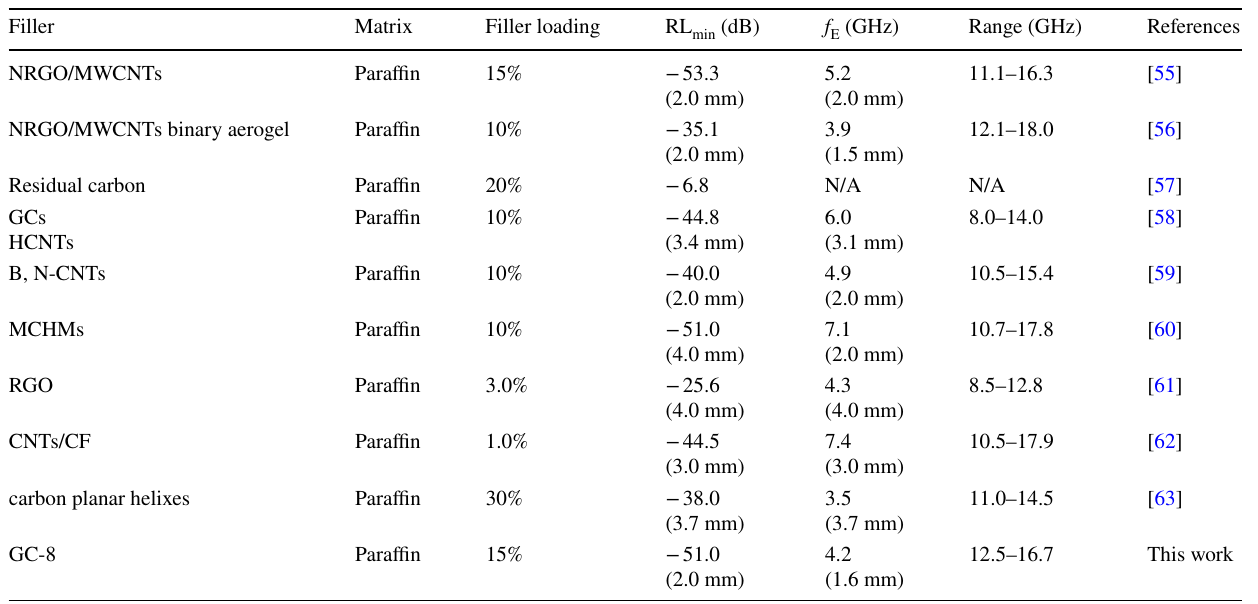
Table 1 EM absorption performance of different carbon materials Filler